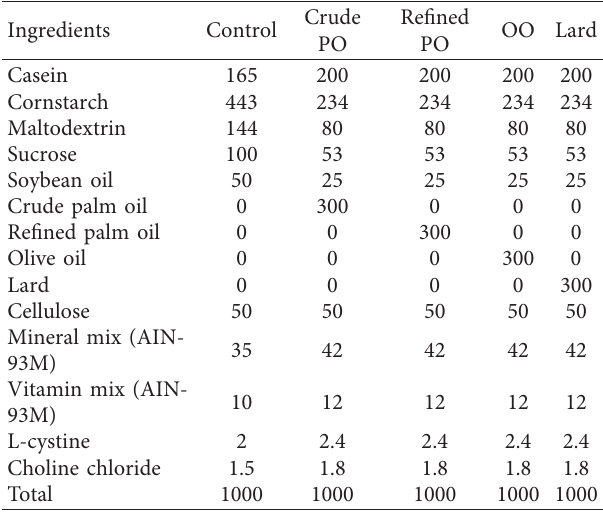
Table 1: Diet composition (g/kg) on the basis of the AIN-93M diet